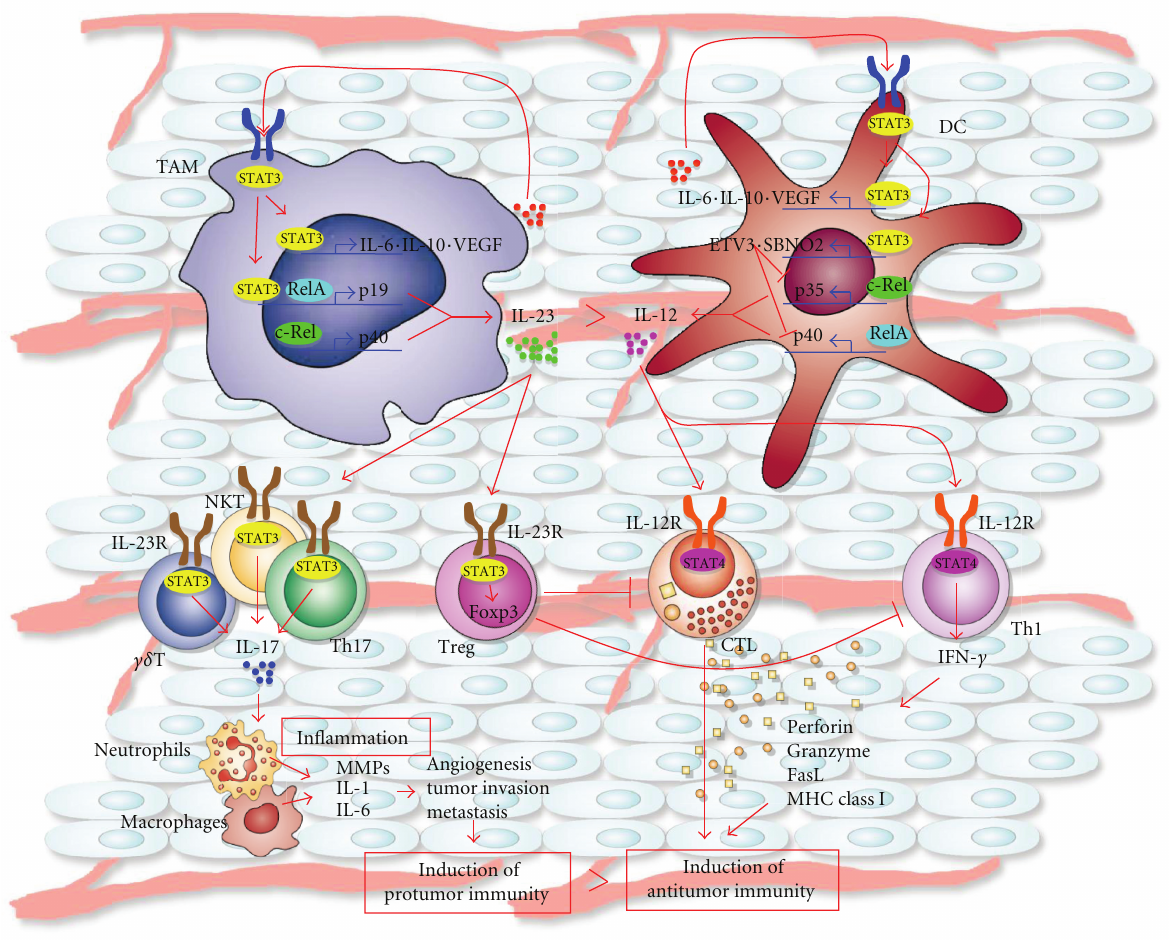
Figure 3: Di ff erences in the immune responses to tumor induced by IL-12 and IL-23 and their molecular mechanisms in tumor microenvironments. STAT3 activation induces IL-23 expression, which is mainly observed in TAMs, via direct transcriptional activation of the IL-23p19 gene together with NF- κ B/RelA(p65). On the other hand, STAT3 activation inhibits NF- κ B/c-Rel-dependent IL-12p35 gene expression in tumor-associated DCs, possibly through the STAT3-dependent induction of the ETS transcriptional suppressor ETV3 and the helicase family corepressor SBNO2. Thus, STAT3 promotes IL-23-mediated protumor immune responses while inhibiting IL-12-dependent antitumor